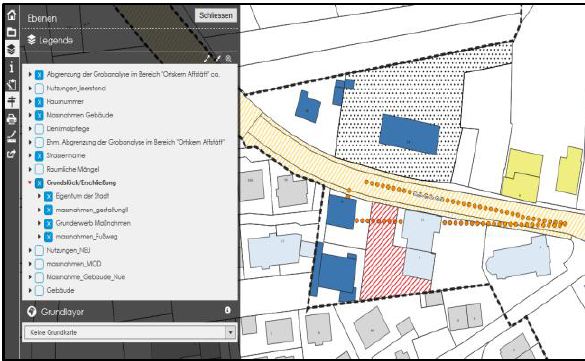
Figure 9 : Lizmap web client application with different layer categories and symbologies.